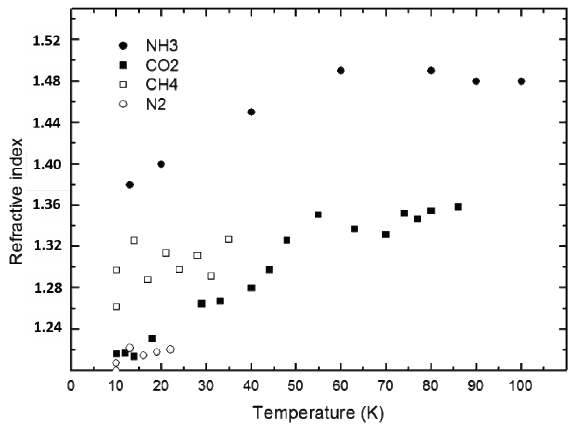
Figure 14. Refractive index values of CH 4 , N 2 , CO 2 and NH 3 for different gas-phase deposition